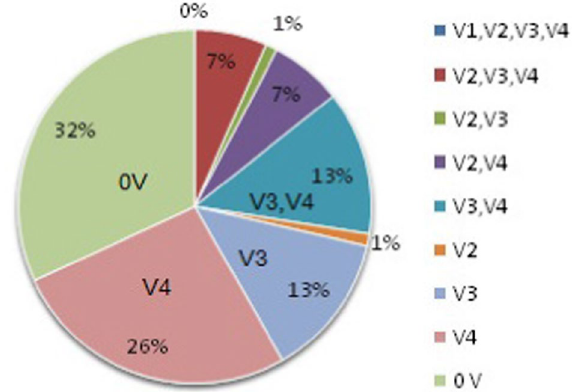
Fig. 7 Distribution of works according to the used Big Data dimensions’